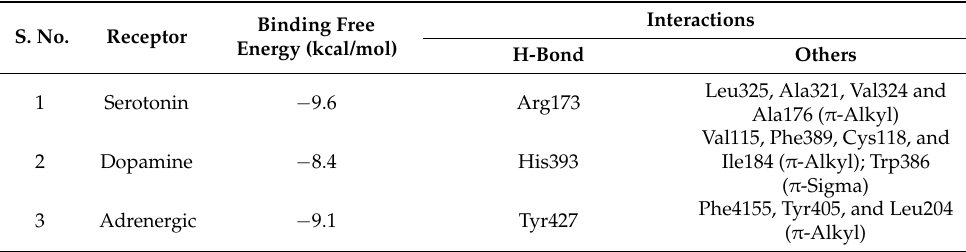
Figure 4. Best docked pose showing a helical model of serotonin, dopamine, and adrenergic receptors docked with ( a – c ) risperidone and ( d – f ) CTcS complexes. Table 2. Docking scores of risperidone and its interactions with receptors.